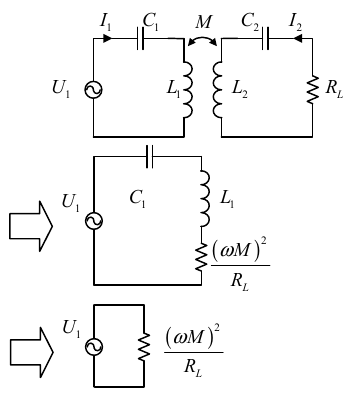
Figure 4. The SS compensation Witricity circuit using the equivalent circuit B.